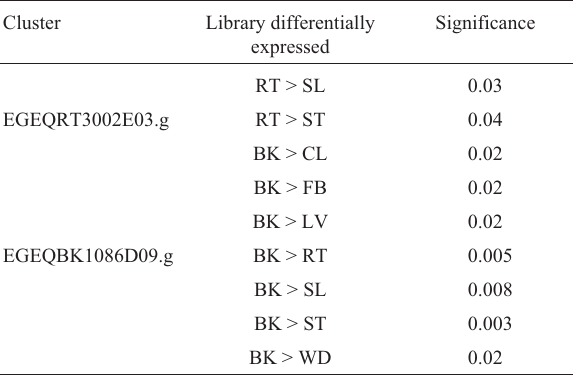
Table 2 - Contigs with differential expression in FORESTs database, analyzed by the Audic and Claverie statistic test (1997), with p <